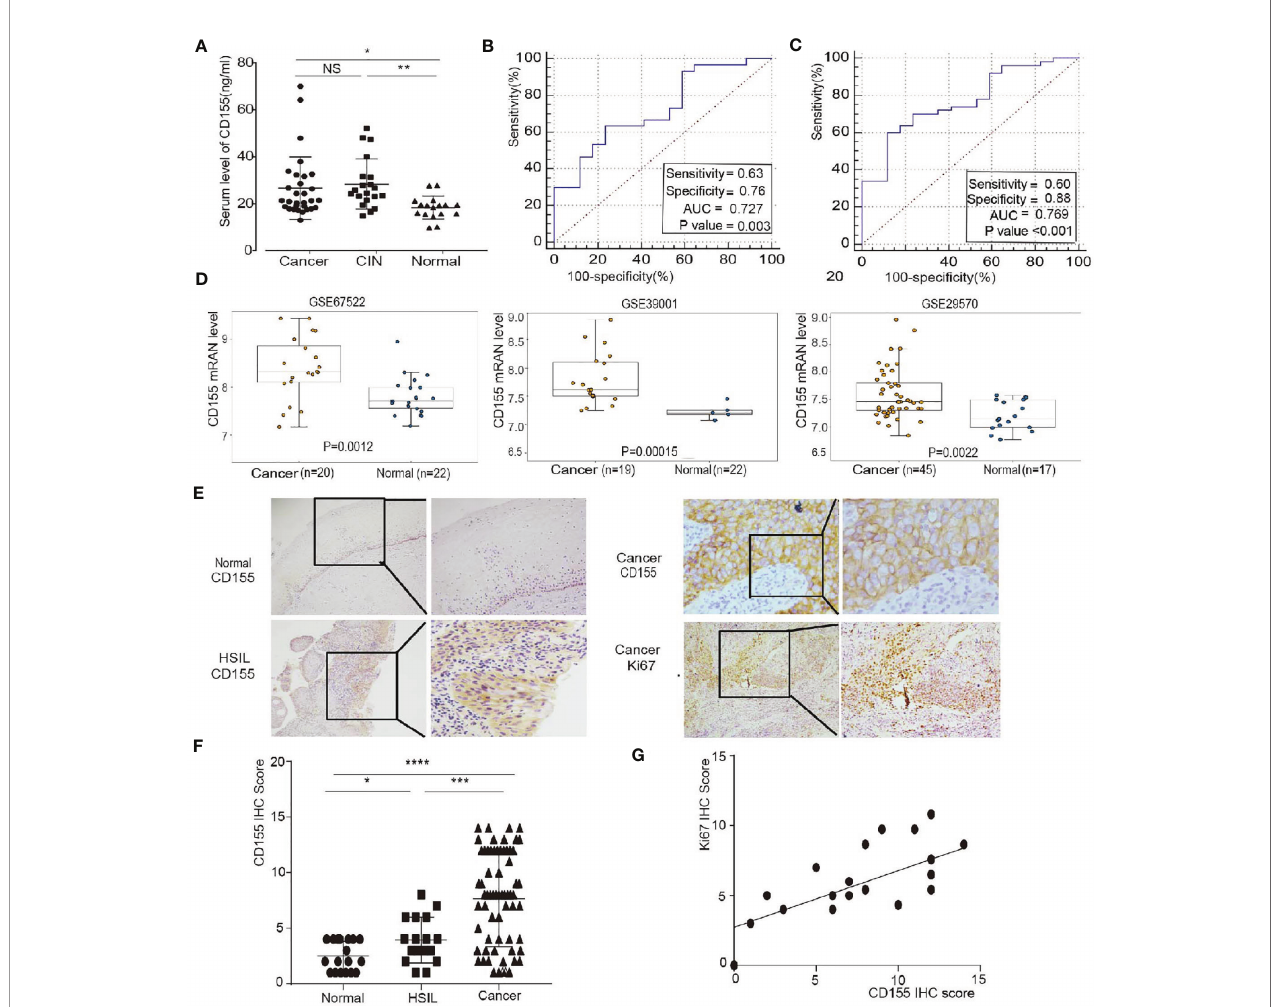
FIGURE 1 | CD155 expression is up-regulated in patients with cervical cancer and HSIL and is positively correlated with Ki67 expression. (A) Distribution of serum CD155 levels CD155 in healthy women (n=17), HSIL patients (n=20) and cervical cancer patients (n=30). (B, C) Receiver operating characteristic (ROC) curve analysis of normal versus cervical cancer tissues and normal versus cervica cancer + HSIL tissues. The area under the ROC curve (AUC) was calculated for the diagnosis of cervical cancer. (D) Validation of CD155 expression in three GEO datasets: GSE67522, GSE39001 and GSE29570. CD155 mRNA levels were compared using Student ’ s t-test in the “ limma ” software package. (E) Representative images of CD155 immunohistochemistry (IHC) staining in normal cervical tissue (n = 18), HSIL tissue (n=20), and cervical cancer tissue (n=66). (F) Representative images of Ki67 IHC staining in cancer tissue (left: 100x, right: 200x). (G) CD155 expression was signi fi cantly positively correlated with the expression of Ki67 (r = 0.6608, P = 0.0004) in cervical cancers (data from IHC scores). NS, no signi fi cant. *P < 0.05, **P < 0.01, and ***P <